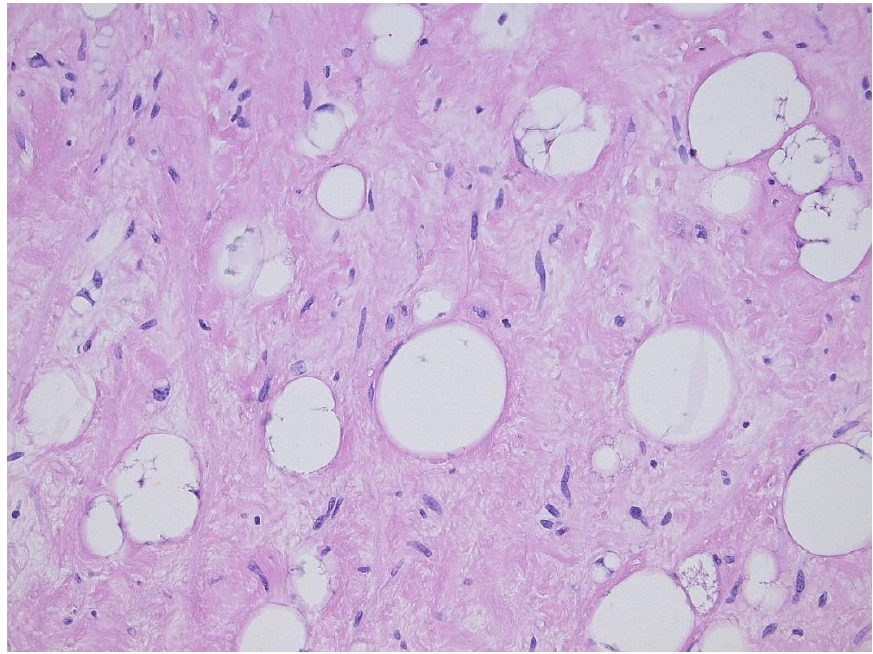
Figure 2. Sclerosing variant of well-differentiated liposarcoma/atypical lipomatous tumor, highlighting the scattered lipoblasts in a sclerotic background.